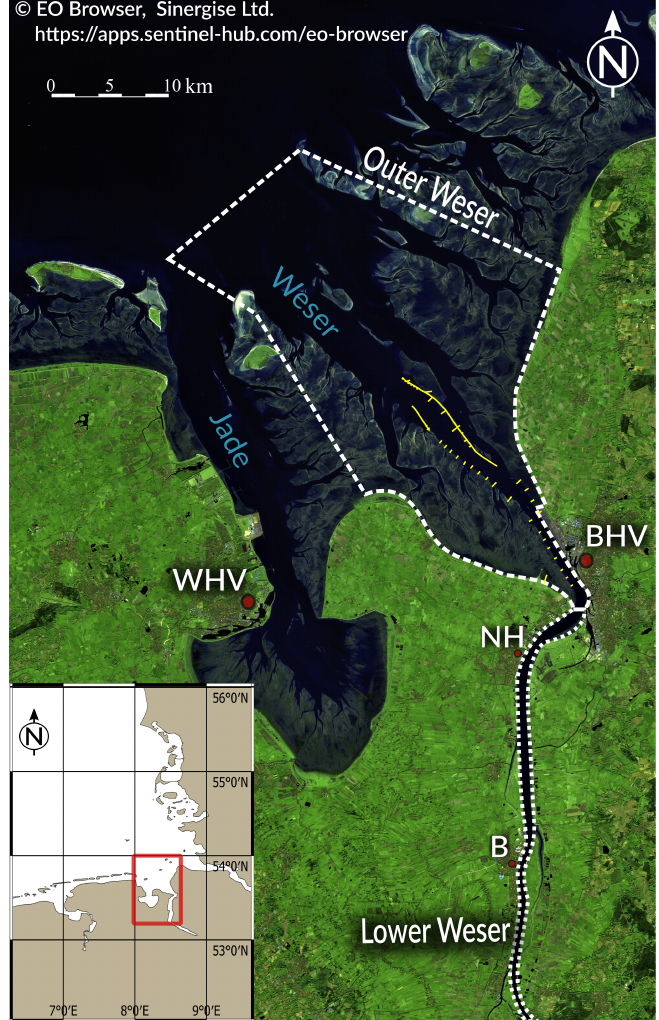
Figure 1. The Weser Estuary divided into the Outer Weser the Lower Weser and the adjacent Jade Bay. The cities of Bremerhaven (BHV), Nordenhamm (NH), Brake (B) and Wilhelmshaven (WHV) are indicated on the map for reference. The small map (Open Street Map) gives the location of the Weser Estuary in the German Bight and the satellite image taken from Copernicus Sentinel-2 (ESA) shows the present channel and shoal pattern in the Outer Weser with the constructed training walls and groynes marked in